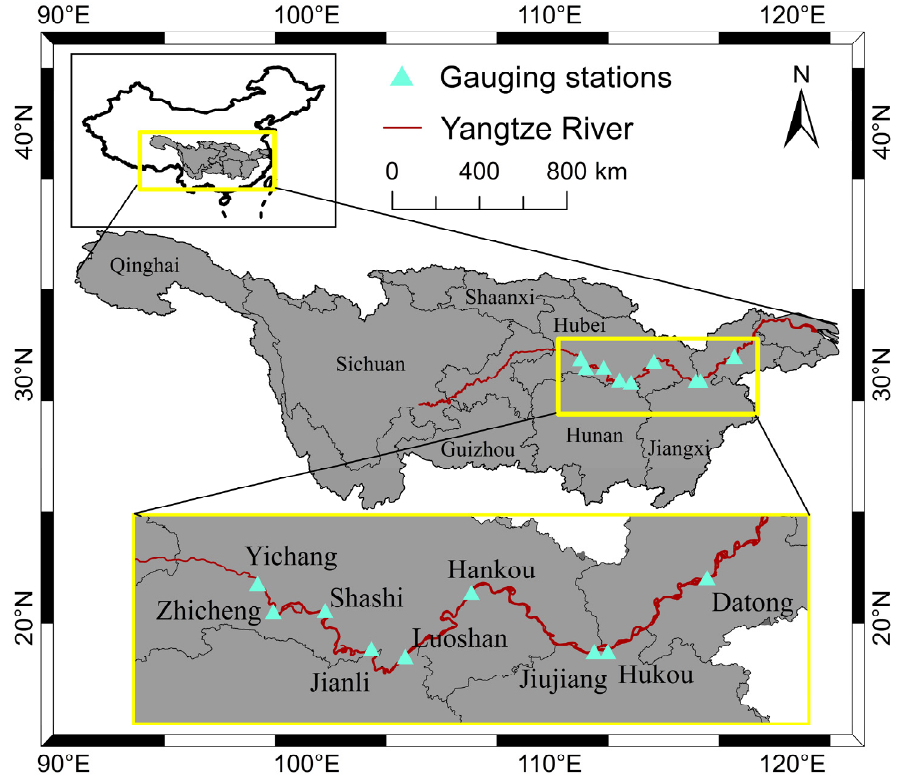
Figure 1. Schematic of the study area and the collected gauging